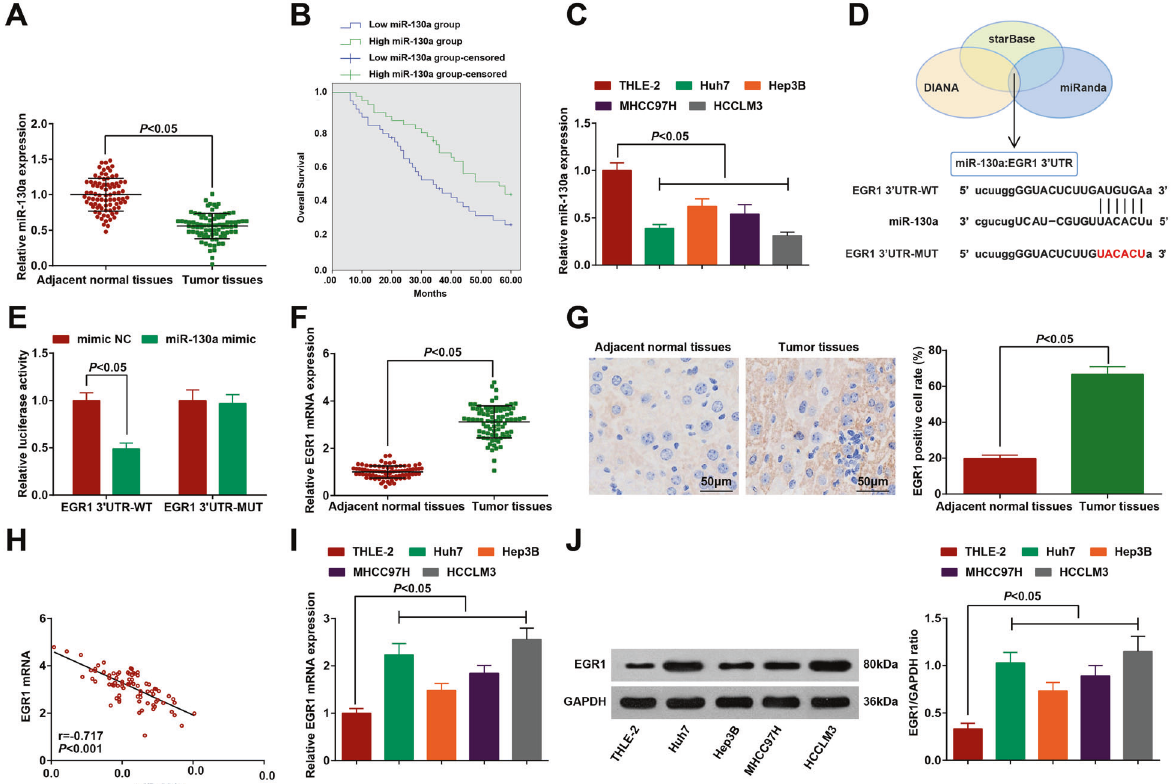
Fig. 1 HCC tissues and cells show reduced miR-130a and elevated EGR1; miR-130a targets EGR1. A miR-130a expression in HCC tissues and adjacent normal tissues detected by RT-qPCR ( n = 83); B The prognostic value of miR-130a in HCC patients; C miR-130a expression in HCC cells detected by RT-qPCR ( N = 3); D Predicted binding sites of miR-130a and EGR1 3 ’ -UTR, and mutant sites of EGR1 3 ’ -UTR in EGR-WT reporter; E The targeting relation between miR-130a and EGR1 veri fi ed by dual-luciferase reporter gene assay; F EGR1 expression in HCC tissues and adjacent normal tissues detected by RT-qPCR ( n = 83); G EGR1 expression in HCC tissues and adjacent normal tissues detected by immunohistochemistry (scale bar = 50 μ m; n = 83); H Correlation between EGR1 and miR-130a expression in HCC tissues detected by Pearson test ( n = 83); I, J EGR1 expression in normal hepatocytes and HCC cells detected by RT-qPCR and western blot analysis ( N = 3); The data were expressed as mean ± standard deviation and compared by t -test or one-way